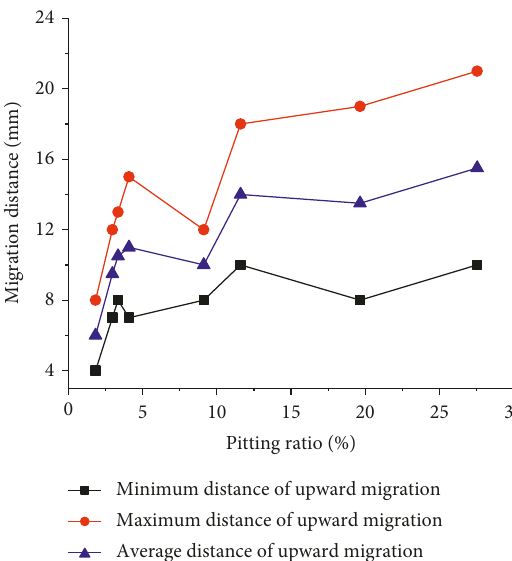
Figure 8: Diagram of upward migration pattern.